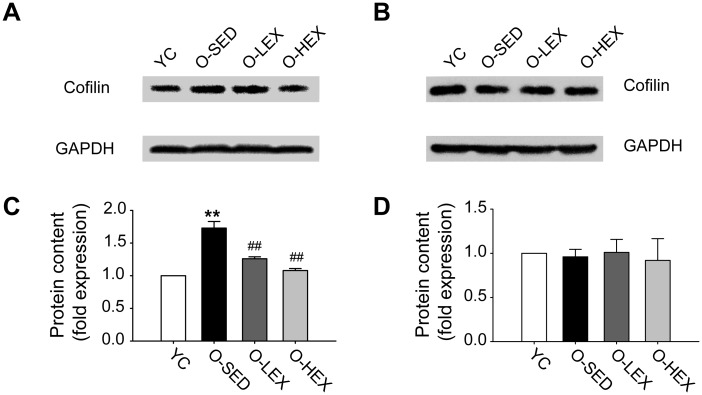
Exercise decreased the increased expression of cofilin in the cortex during aging.(A-B) Immunoreactive bands corresponding to cofilin and GAPDH in the cortex (A) and hippocampus (B). (C-D) Summarized data of cofilin protein levels (as a ratio to GAPDH) in the cortex (C) and hippocampus (D). Values are mean and standard error of the mean, n = 5 in each group. ** P< 0.01 vs. YC, ## P< 0.01 vs. O-SED.